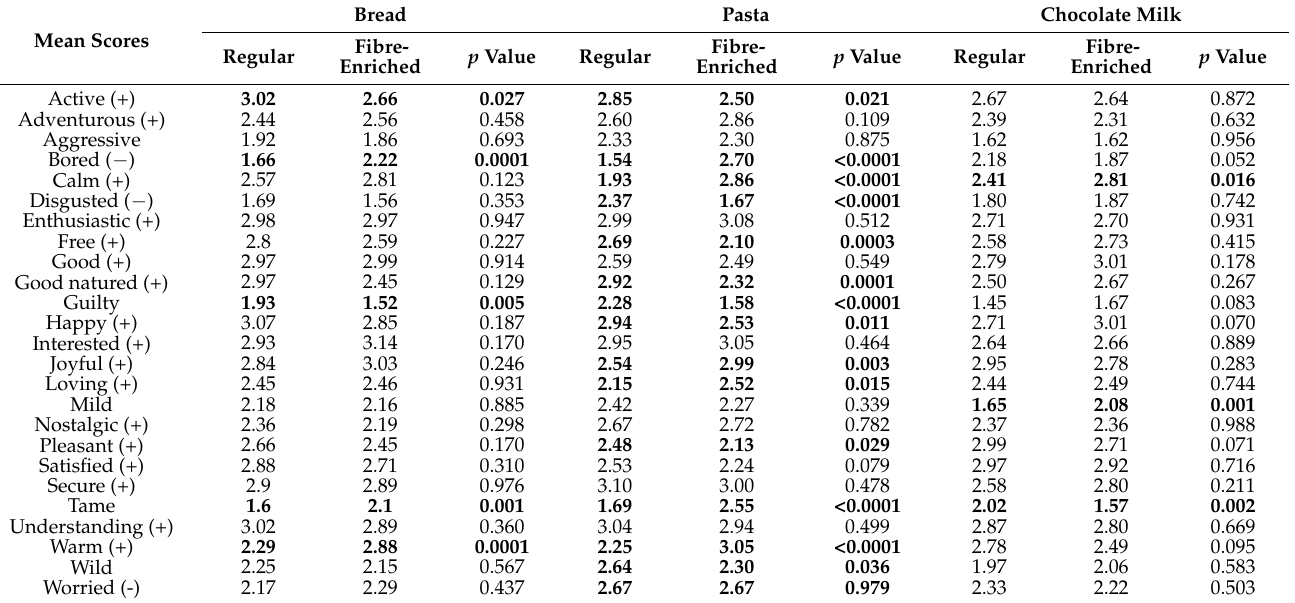
Table 7. Effect of product on consumers’ emotional response for bread, pasta and chocolate milk.